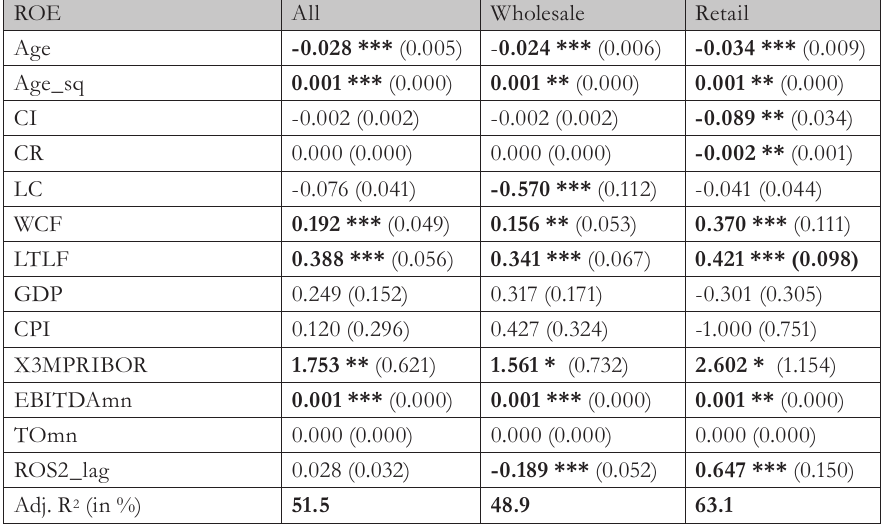
Tab. 4 – Determinants of returns on equity (ROE): estimation results (standard errors in parentheses). Source: own